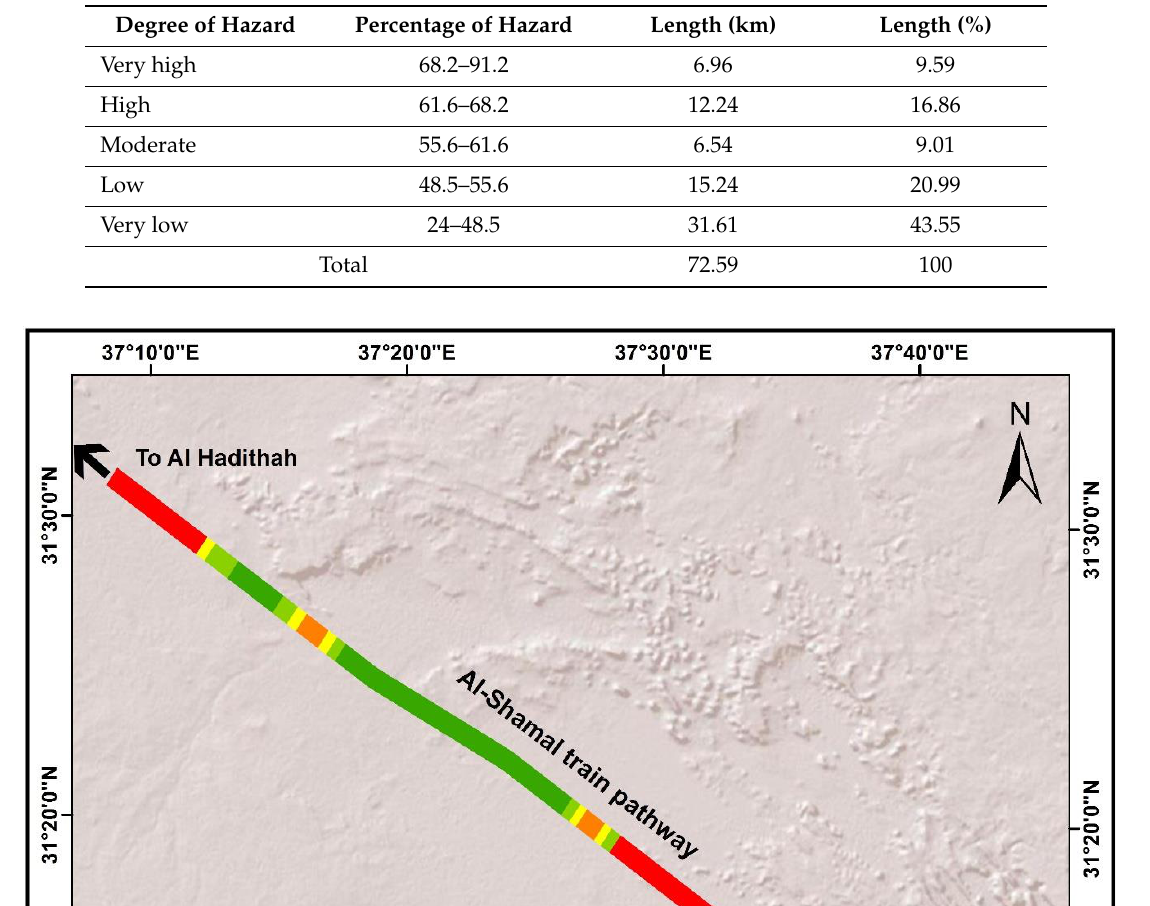
Table 21. Flood hazard degrees on the Al-Shamal train pathway in the study area in 2020.